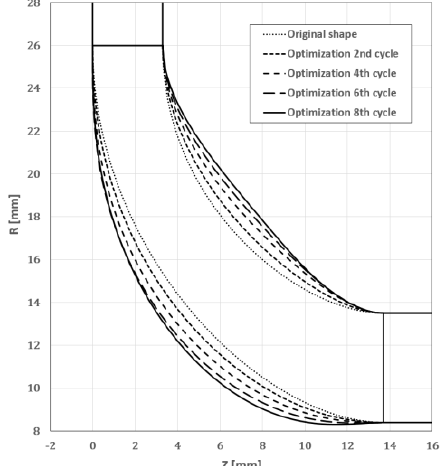
Figure 13. Comparison of hub and shroud meridional contours obtained by shape optimization.